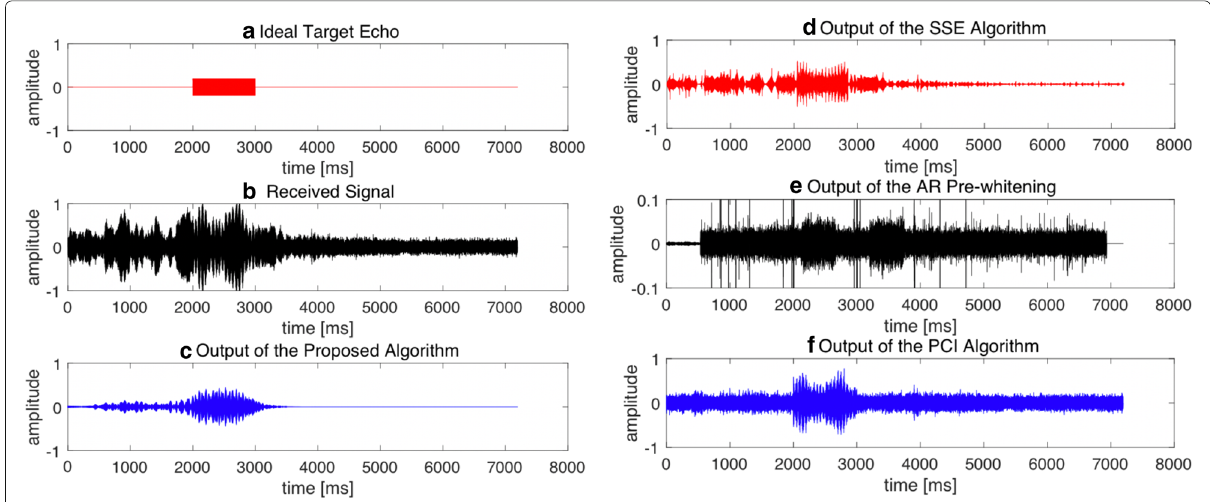
Fig. 13 Experimental results from measurements in an ocean. a The ideal target echo, b received signal comprising target echo and reverberation, c output from the proposed algorithm, d output from the SSE algorithm, e output from the AR pre-whitening, and f output from the PCI algorithm are